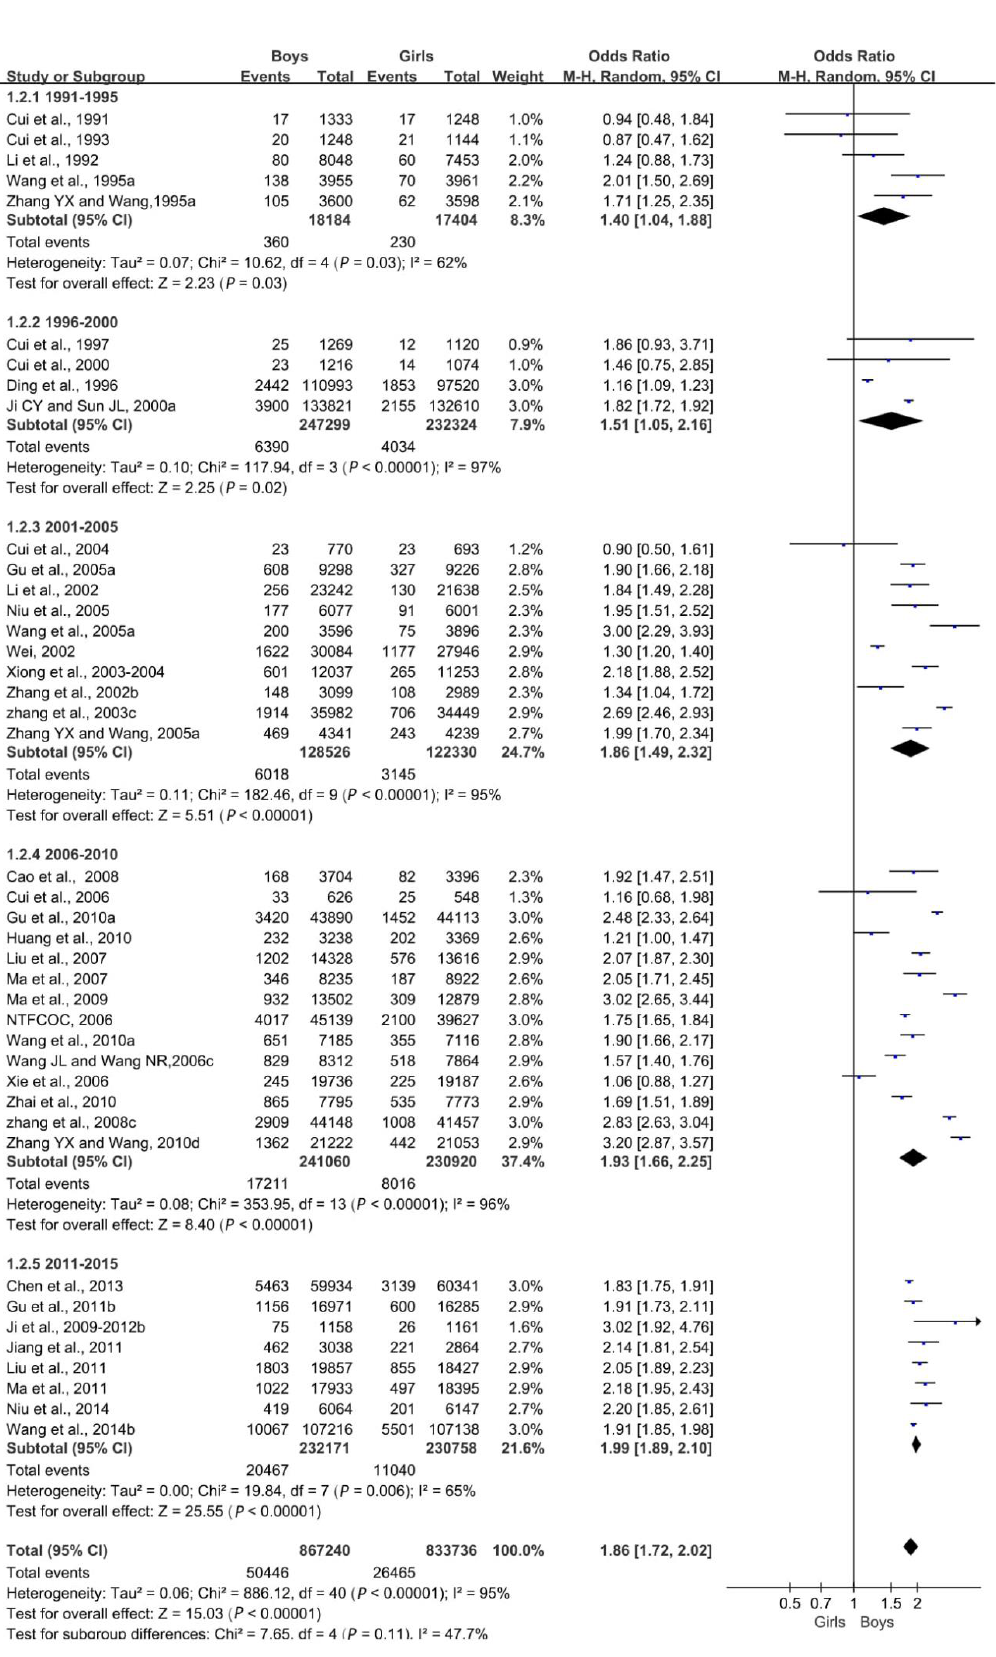
Figure 4. Forest plot of obesity in boys compared with girls aged 0 – 18 years.